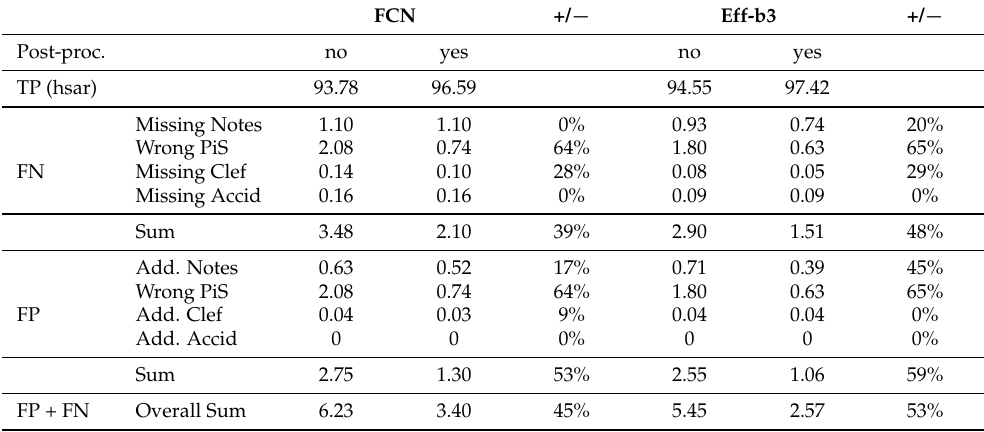
Table 9. Listing of symbol segmentation error types of the models and their quantity in %. The +/ − columns indicate the improvement percentage by which the error type can be reduced by post-processing. The best performing model of the “FCN” and the “Eff-b3” architecture were used (fine-tuning + post-processing). The edit-distance of the predicted sequence and the GT without the usage of replacements is computed. Thus, PIS errors were treated as a TP and a